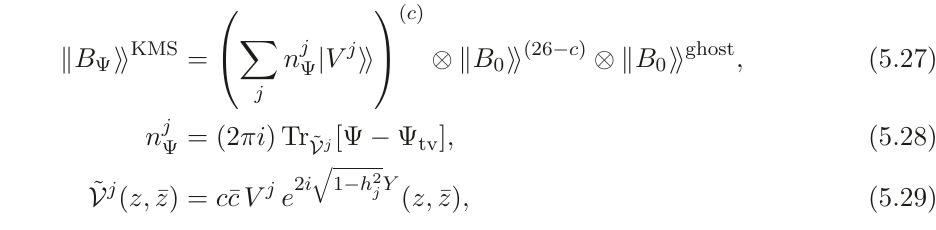
Figure 19 . Defect networks manipulations for the Ellwood invariant of a defect-acted open string- field. The dashed line corresponds to the identification of the left and right part of the open string, via the identity conformal map f (1) ( z ) = normalizations and the consequent F -matrix orthogonality relation, only the identity defect p = 1 stretches between the boundary and the defect d , making d a genuine closed string defect. When V = 1 this also gives a geometric proof of